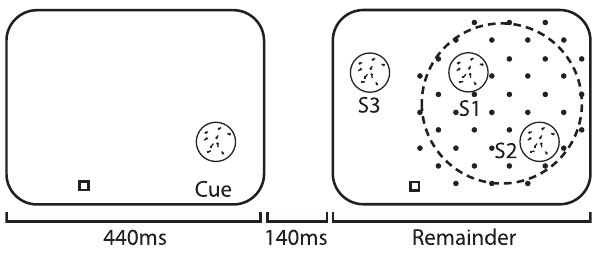
Figure 4. Experimental method used in Womelsdorf et al. [3] . See text for